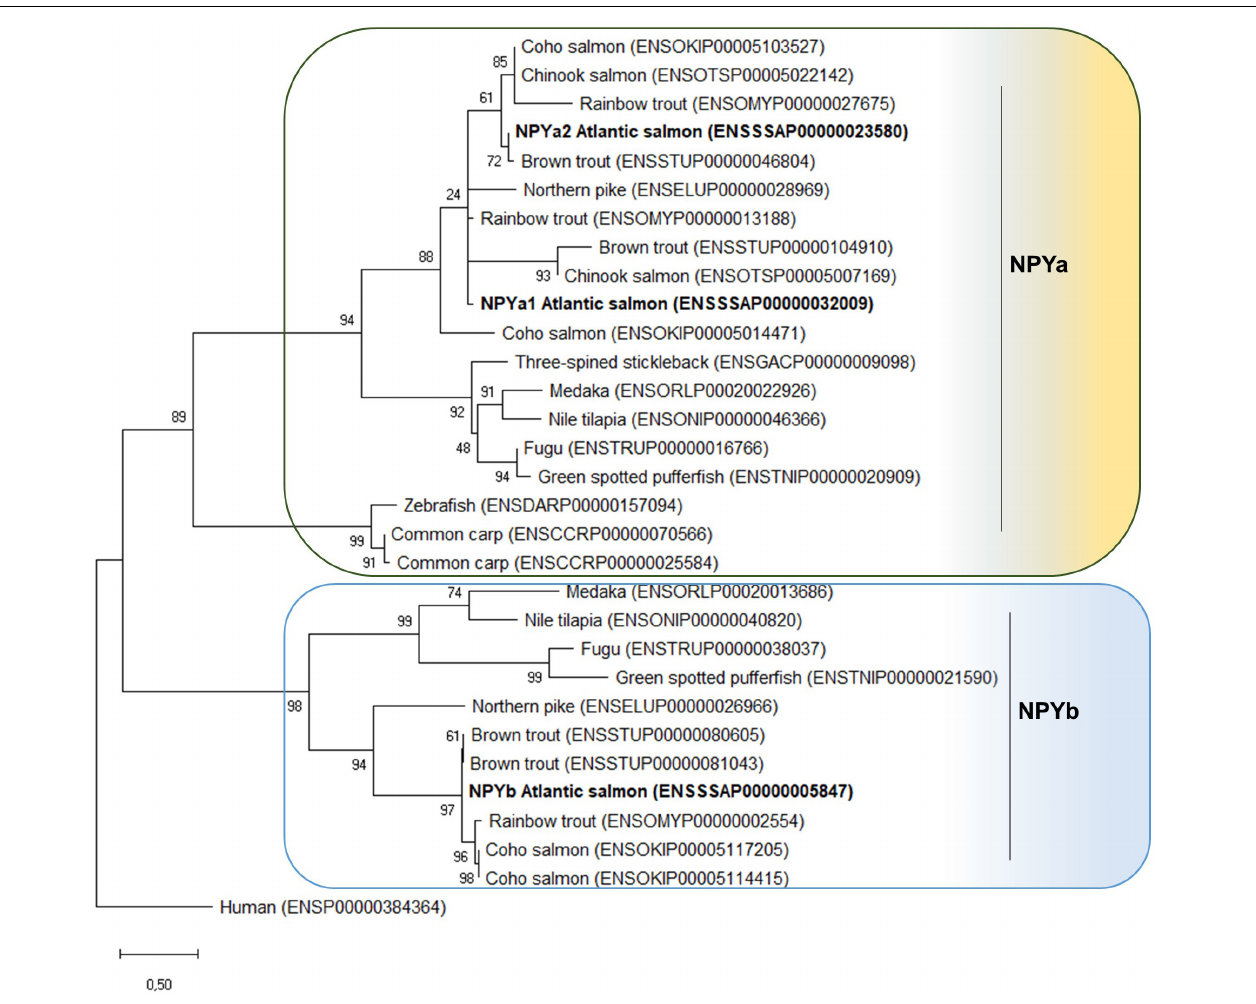
FIGURE 2 | Phylogenetic tree of the NPY family peptide in teleosts. The phylogenetic tree was constructed based on the NPY predicted full-length amino acid sequences using the Maximum Likelihood method and JTT matrix-based model with fixed Gamma distribution parameter with five rate categories, and 1000 bootstrap replicates. The tree was rooted to the human NPY sequence. Evolutionary analyses were conducted in MEGAX (Hall, 2013). Accession numbers are provided in front of the common species